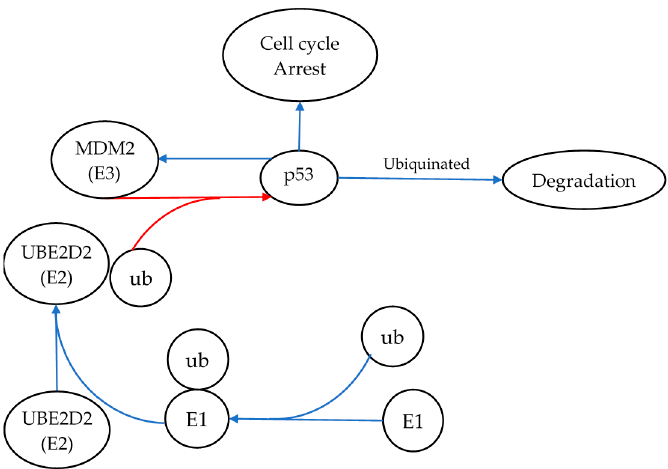
Figure 3. Ube2d2’s role in p53 degradation, and the signaling pathway demonstrating the role of miR-1228-3p and its target Ube2d2 in regulating the degradation of p53. Here, Ube2d2 is shown transferring ubiquitin (ub) onto p53 via MDM2 and, thus, targeting p53 for degradation. miR-1228-3p inhibits the translation of Ube2d2 . Therefore, radiation-induced expression of miR-1228-3p should reduce Ube2d2-mediated degradation of p53. Thus, increased expression of miR-1228-3p is expected to result in elevated p53 levels. The blue arrows represent pathway activation, whereas the red arrows illustrate pathway inhibition. E1 represents ubiquitin-activating enzymes that catalyze the first step in the ubiquitination